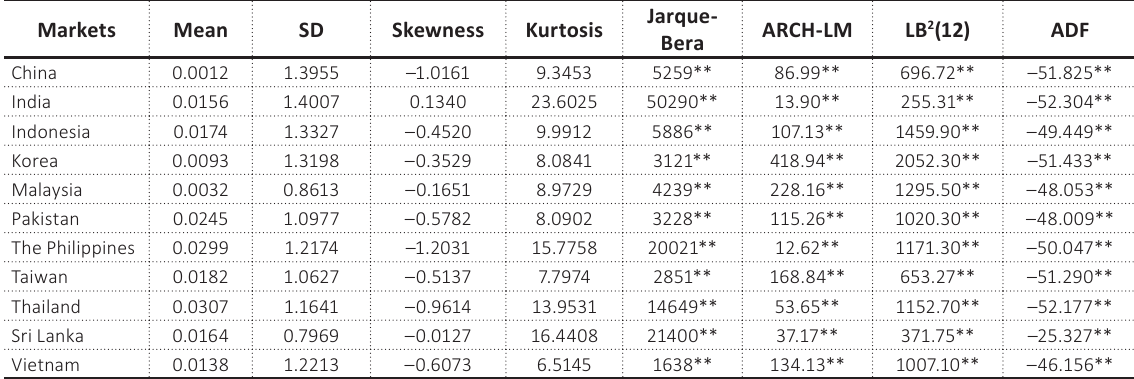
Table 3. Descriptive statistics of the stock returns during post-global financial crisis